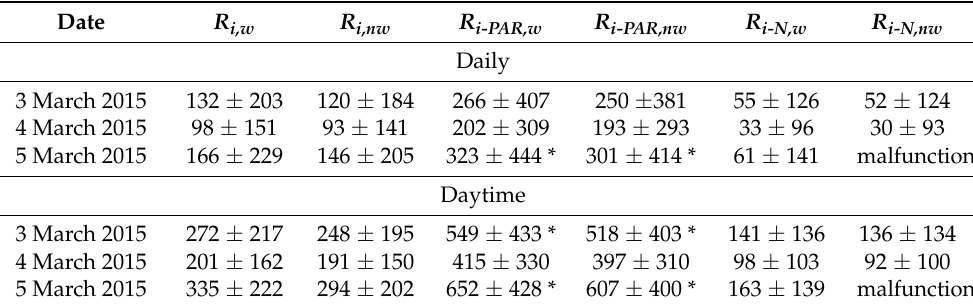
Table 2. Radiation levels inside the greenhouse [average value ± standard deviation]. R i , inside